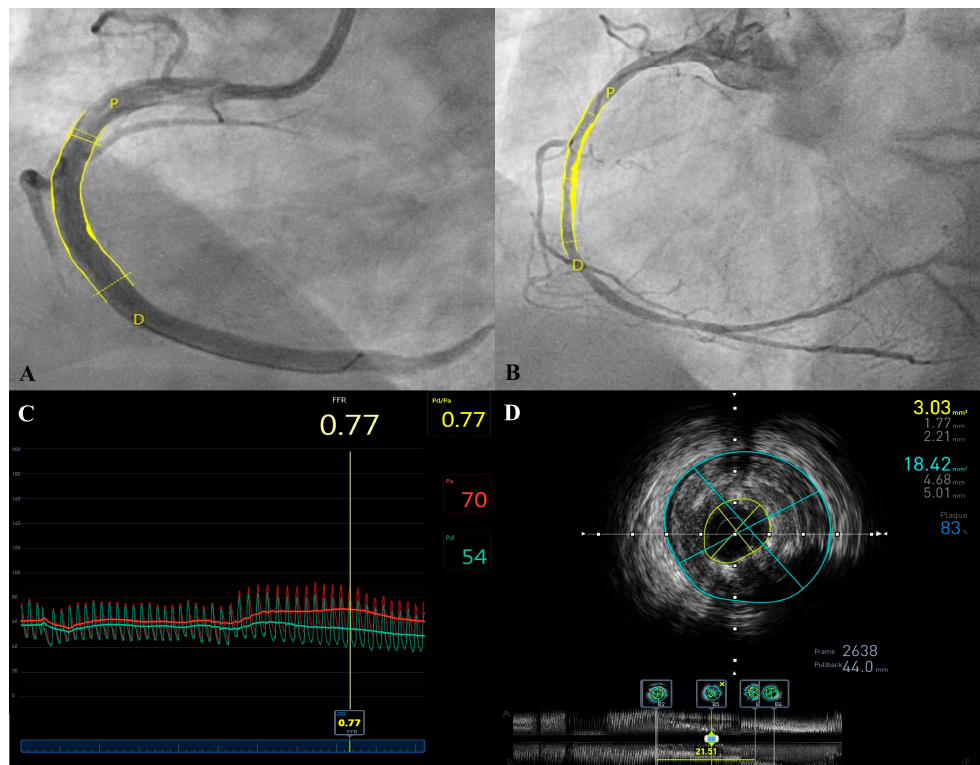
Figure 2. In-stent restenosis post-implantation of one DREAMS-2G stent in a right coronary artery lesion. MLD by QCA post-stent implantation was found to be 3.13 mm; reference 3.93 mm (Panel ( A )). In-stent restenosis was found 8 months post-implantation with MLD by QCA of 1.2 mm (Panel ( B )). Pathological functional assessment by FFR (0.77) was found upon revascularization (Panel ( C )). IVUS pullback showed in-stent restenosis and an MLA of 3.03 mm 2 secondary to a collapse of stent struts more than intrastent neointimal proliferation, the plaque burden was 83% (Panel ( D )). FFR = Fractional Flow Reserve; IVUS = Intravascular Ultrasound; MLA = Minimal Lumen Area; MLD = Minimal Lumen Diameter; QCA = Quantitative Coronary Angiography.